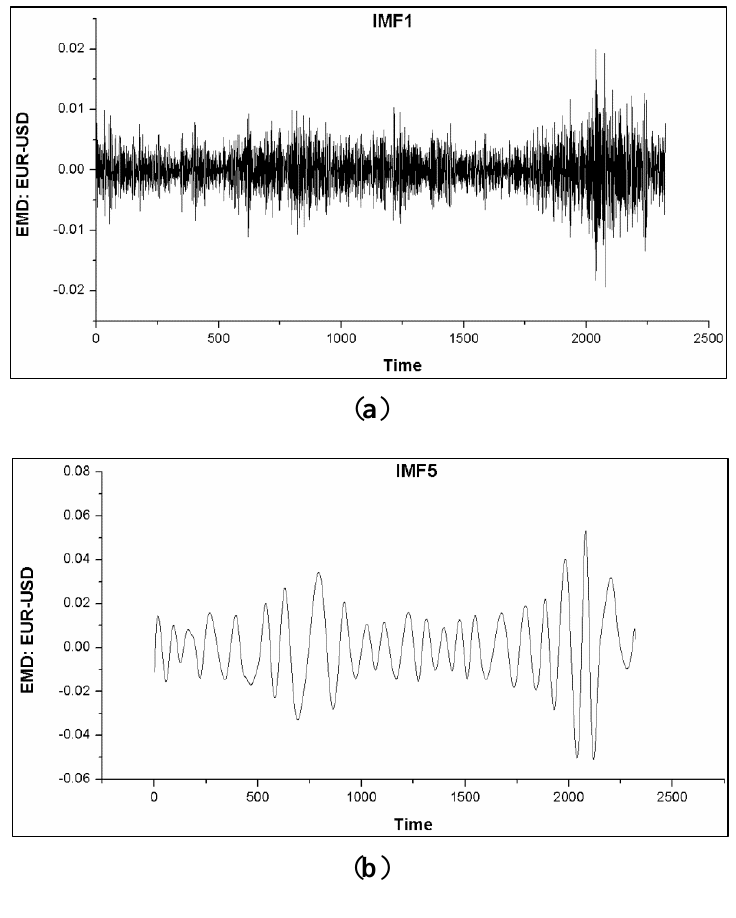
Figure 11. Graphs ( a )–( c ) show plots of IMF1, IMF5 and IMF7, of which their local extrema of higher order IMF moved toward the normal